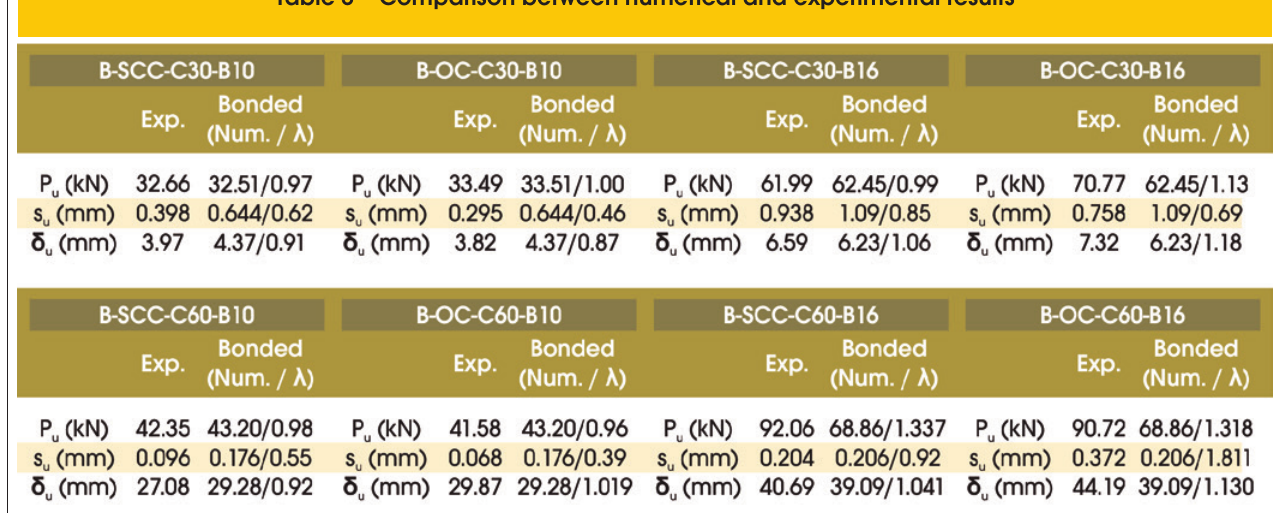
Table 5 – Comparison between numerical and experimental